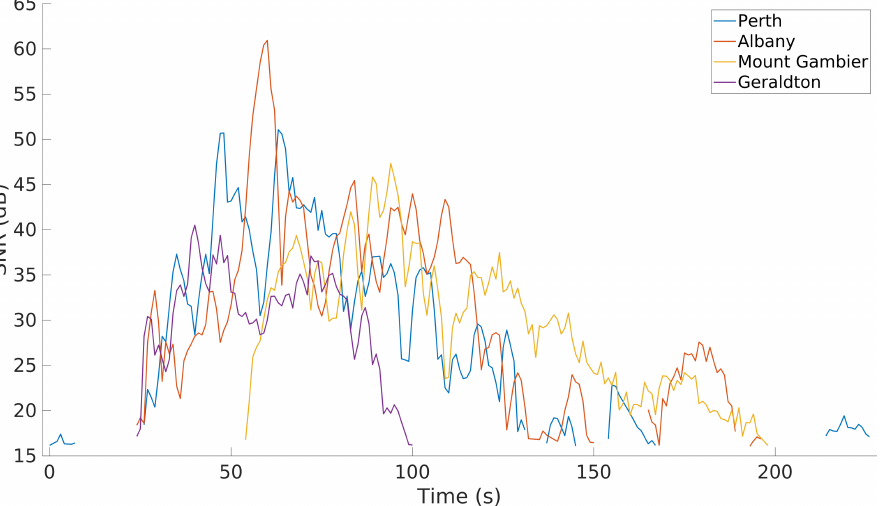
Figure 15. An example pass showing the signal to noise ratio (SNR) of International Space Station detections utilising all the transmitters covered in this section.